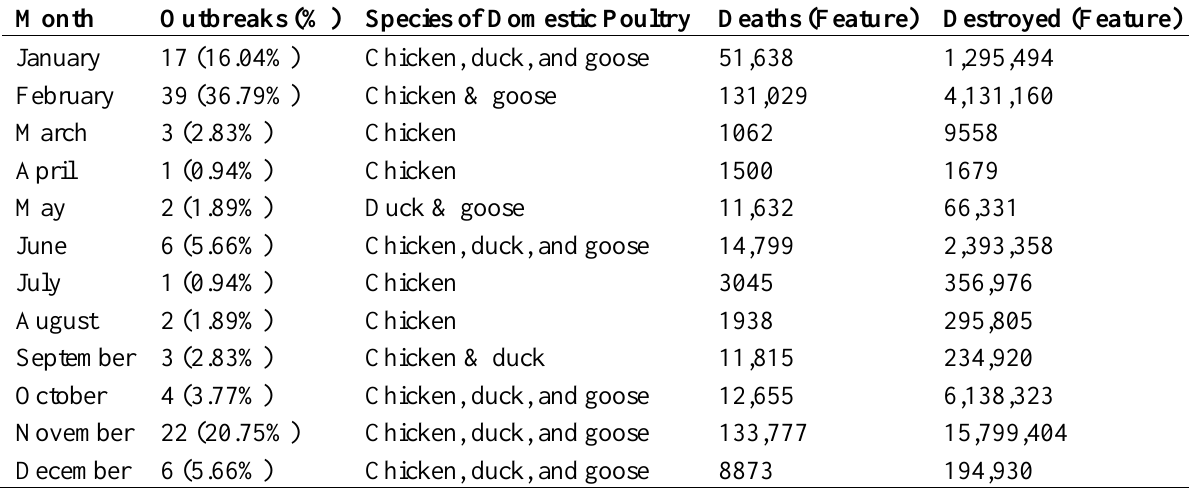
Table 1. Summary of outbreaks of HPAI H5N1 in domestic poultry for each